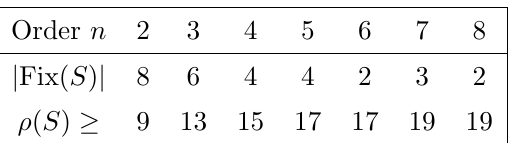
Table 1 . Symplectic automorphism orders and number of (cid:12)xed points for a complex K3 surface S . Here (cid:26) ( S ) is the Picard number of S . Table from ref. [24]. Symplectic automorphisms of order two were studied by Nikulin [25] and are called Nikulin involutions . According to table 1, a Nikulin involution of a complex K3 surface has eight (cid:12)xed points and Picard number (cid:26) ( S ) (cid:21) 9. A classi(cid:12)cation of all algebraic K3 surfaces with Picard number satisfying the lower bound, i.e. (cid:26) ( S ) = 9 can be found in ref. [26]. Open